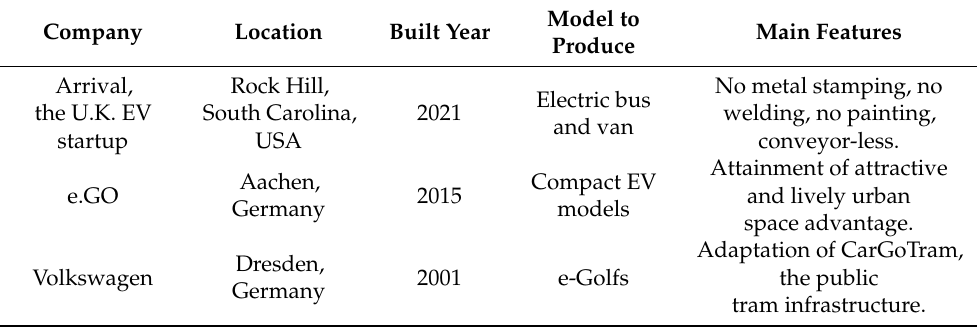
Table 1. Three representative urban car manufacturing